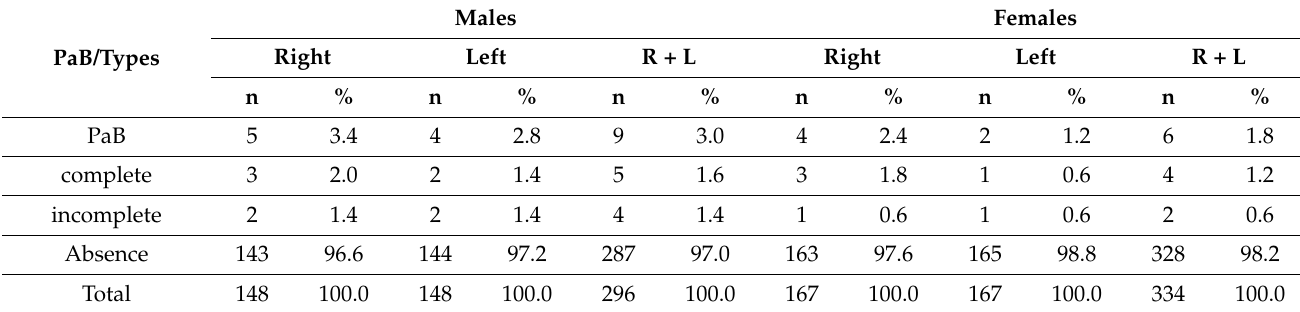
Table 3. Frequency of pterygoalar bridge in both sides and sexes.